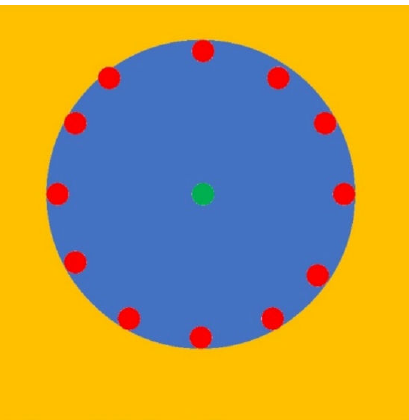
Figure 11. Schematic drawing of an aquifer in the process of being desalinated. Orange = aquifer; blue circle = part of aquifer which is being desalinated (desalination zone). Red = infiltration boreholes/wells; green = abstraction